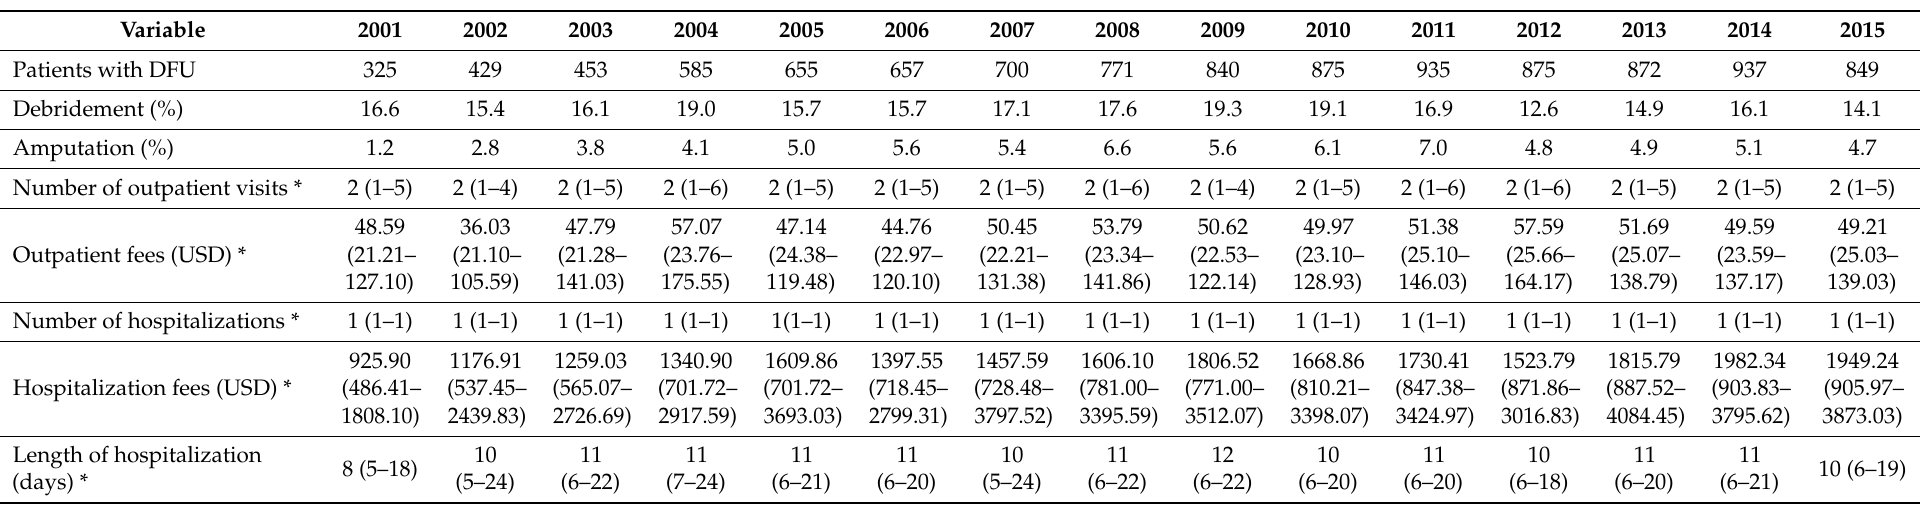
Table 3. Medical expenditure for DFU during